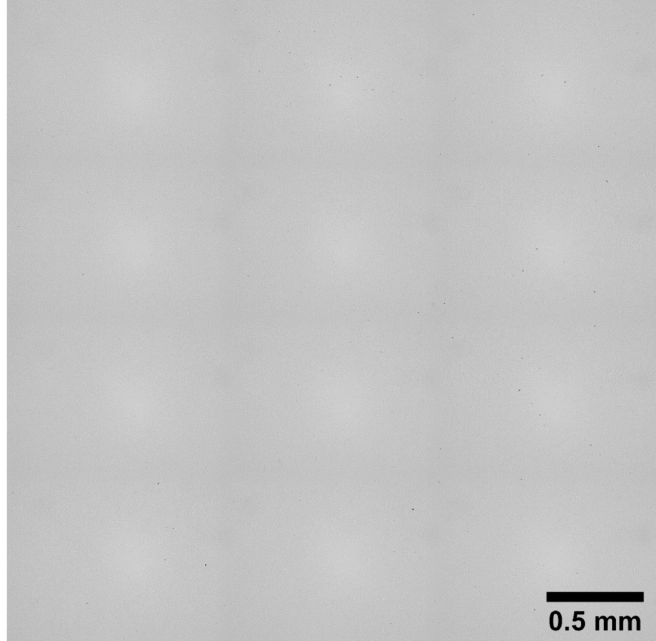
Figure A6. Large-scale (around 3.3 mm × 3.3 mm square) optical micrograph of the MAD542 superalloy heat treated at 1230 ◦ C for 2 h and 900 ◦ C for 24 h (sample preparation: metallographic